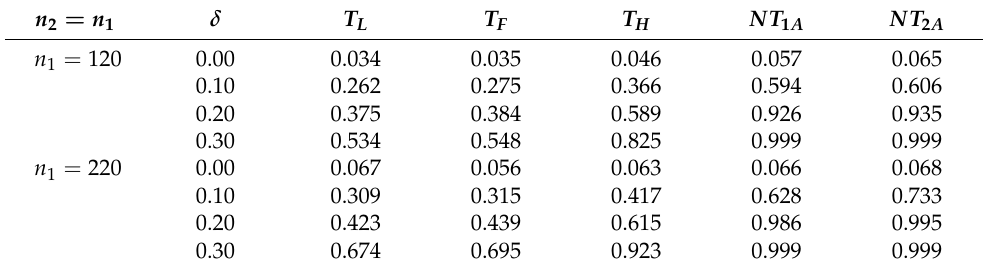
Table 7. Size and power of five methods under randomized signal in Setting 1 M ( 20,6 ) . n 2 = n 1